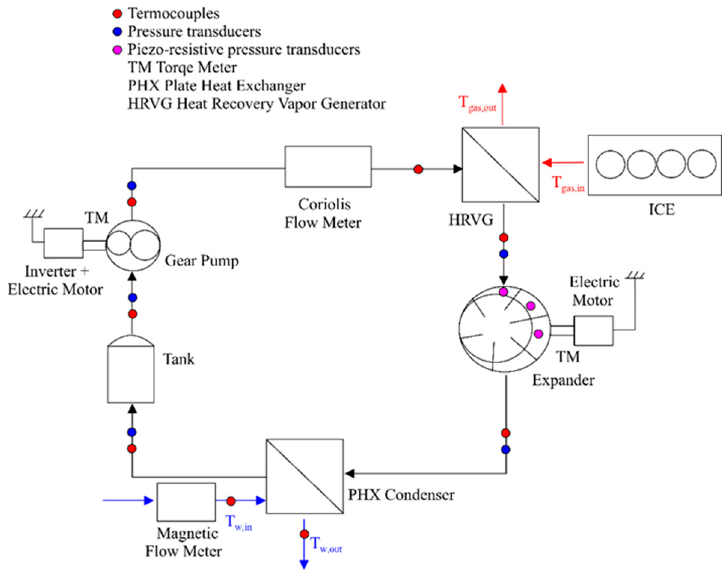
Figure 1. Experimental test bench and measurement instruments layout.